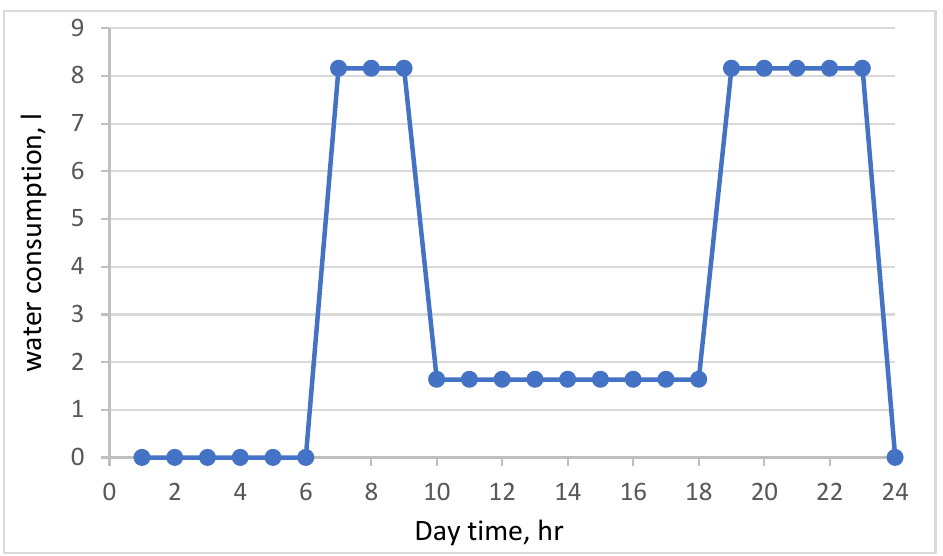
Figure 2. The hot water consumption pattern throughout the day. As for the hot water region, the PCM region was also equipped with two holes and a lid to fill and discharge the PCM at any time based on necessity. Moreover, the problem of high pressure throughout the system is resolved by setting up vents for both the water and the PCM regions. A photographic view and schematic diagram of the system are presented in Figure 3. The water is replenished from the water supply tank. The hot water storage cylinder receives hot water passively from the evacuated tube, whereas the hot water flows up to the tank naturally due to thermosiphon circulation. The hot water was then used for domestic use, and hot water consumption was recovered by the water supply tank. When water gains heat from solar energy, it conductively exchanges this energy with the PCM. Conversely, as the temperature of water decreases, the latent heat will be released to the water from the PCM during the liquid phase until solidification in the absence of the sun.